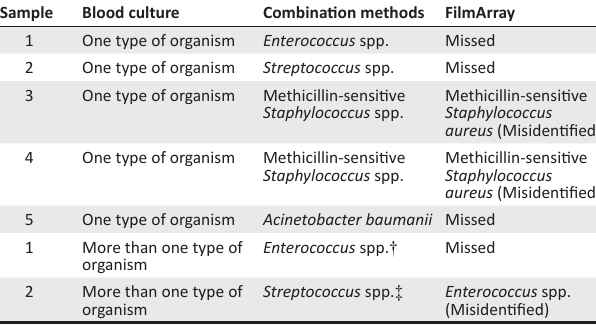
TABLE 4: Breakdown of conflicting results.